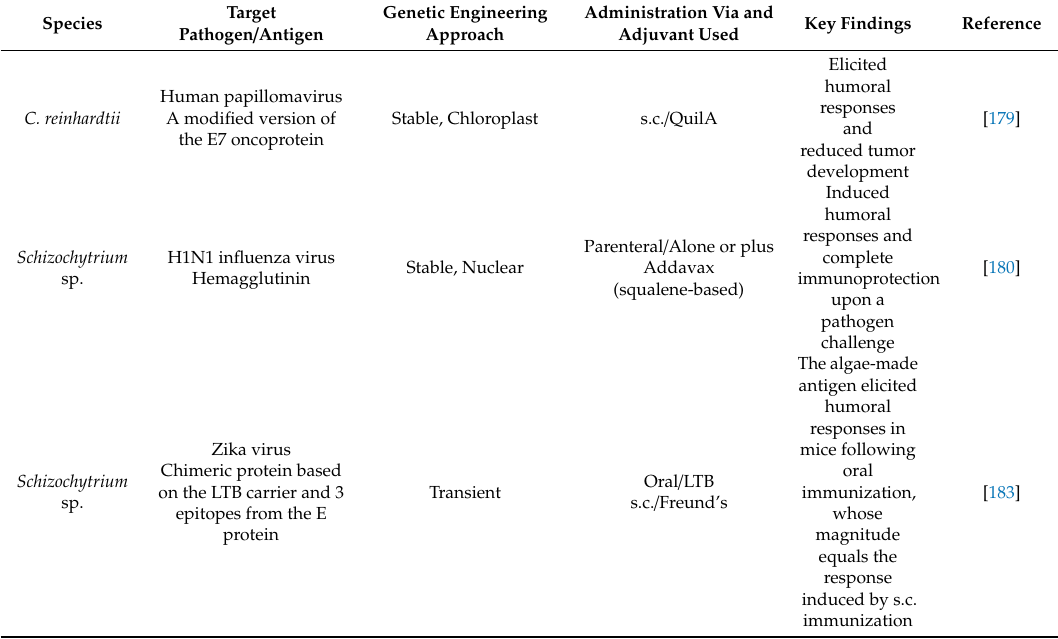
Table 1. Examples of vaccines produced in innovative expression hosts targeting viral